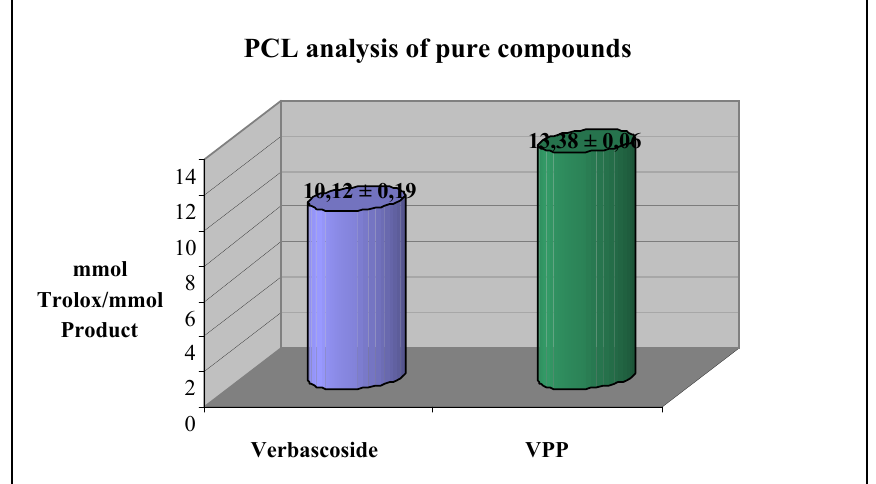
Figure 3. PCL analysis of verbascoside and VPP. Each value was obtained from three experiments (mean ±